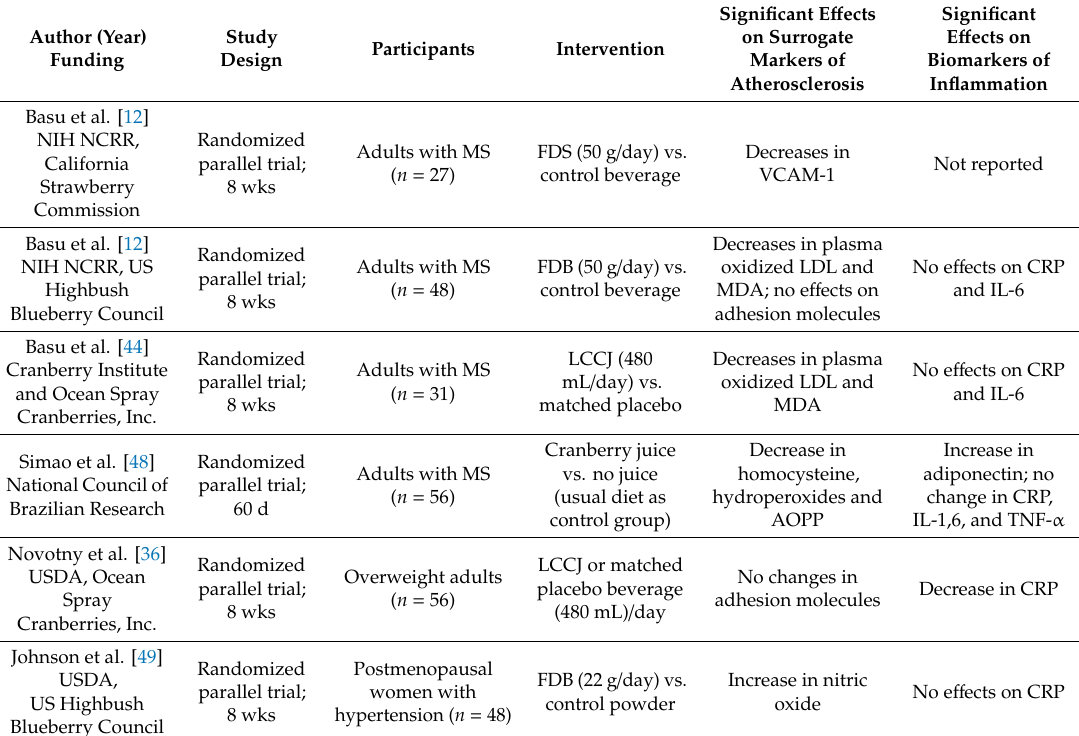
Table 3. E ff ects of dietary berries and markers of atherosclerosis and inflammation: clinical